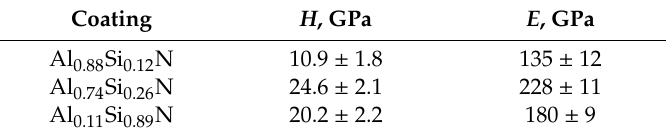
Table 1. Hardness and elastic modulus of Al-Si-N